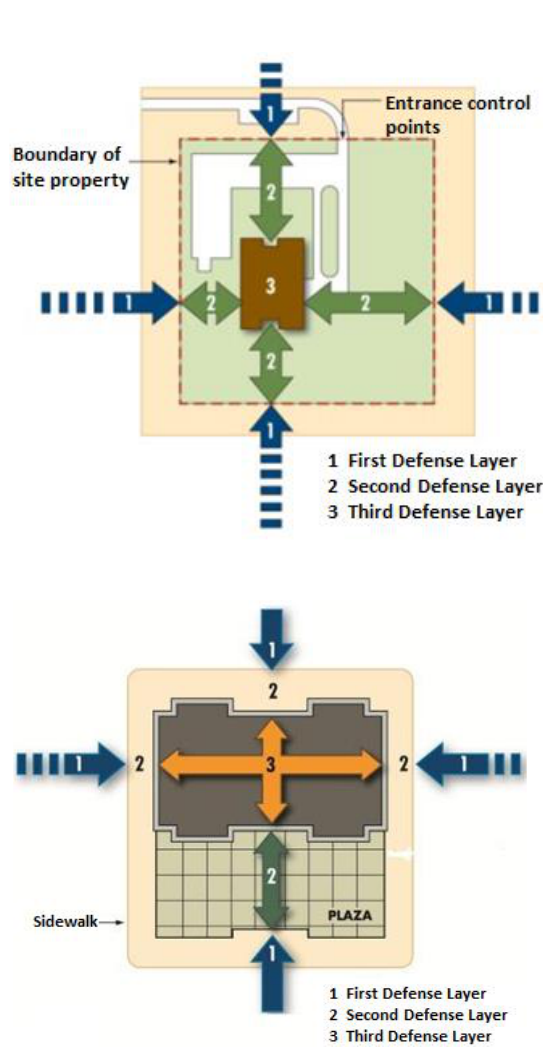
Figure 2. Defense layers; Up: Single building perimeter, Down: Plaza. Perimeter boundary (Site property boundary) determines the security distance around the building that can be uncontrollable for the owner of the building and the people living there (FEMA,